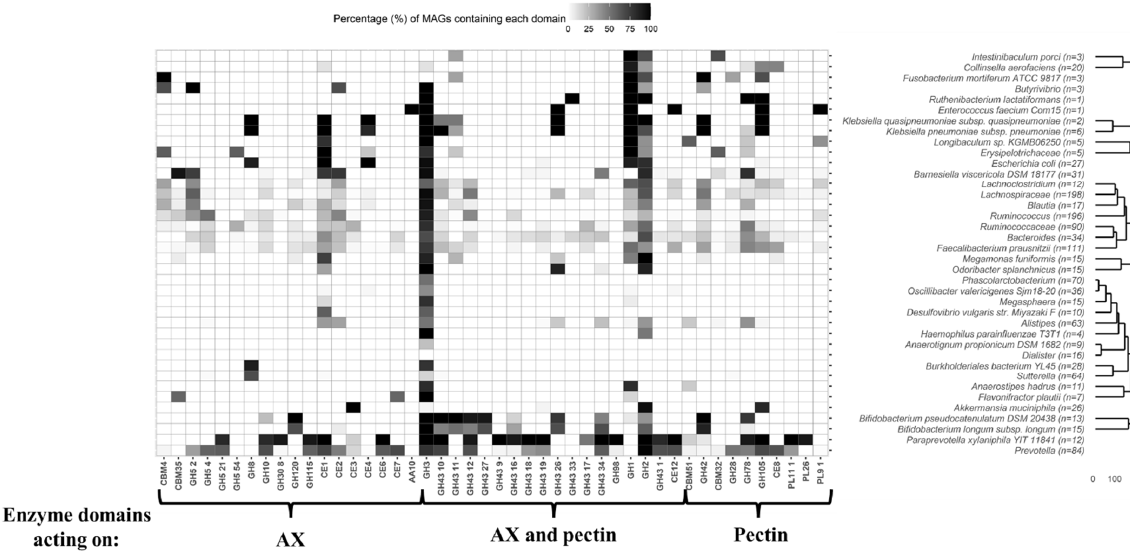
Figure 4. Heatmap showing the presence of different glycosidases (indicated as black cells) in metagenome-assembled genomes (MAGs) recovered from the microbiota of healthy individuals. These MAGs were assigned to taxonomic clades that were also found in the microbiota of patients with Crohn’s disease (see Table 2). The percentage (%) of MAGs containing each functional domain is shown. Specifically, glycosidases capable of degrading arabinoxylan (AX) and pectin are illustrated. Glycosidase functional domains showing coverage values higher than 0.95 were annotated. Codes corresponding to the Carbohydrate ‐ Active enZYmes Database (CAZy) family of each enzyme have been assigned.